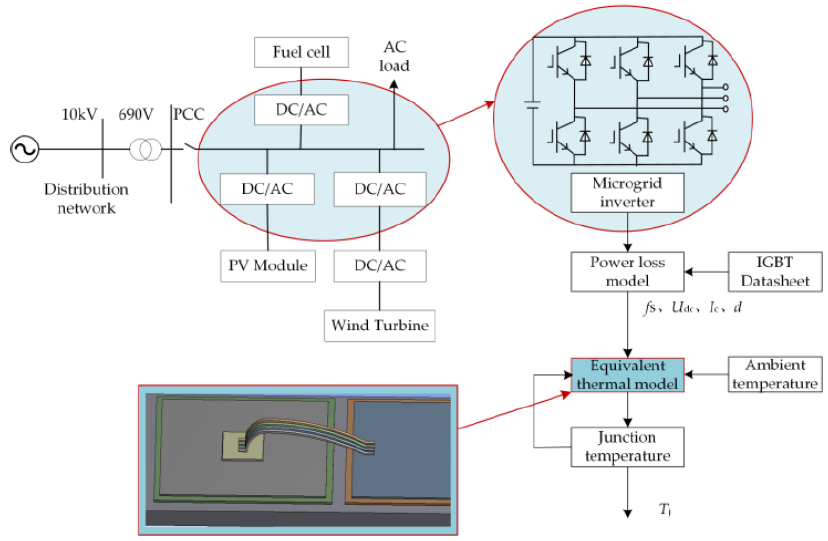
Figure 1. Electrothermal coupling model